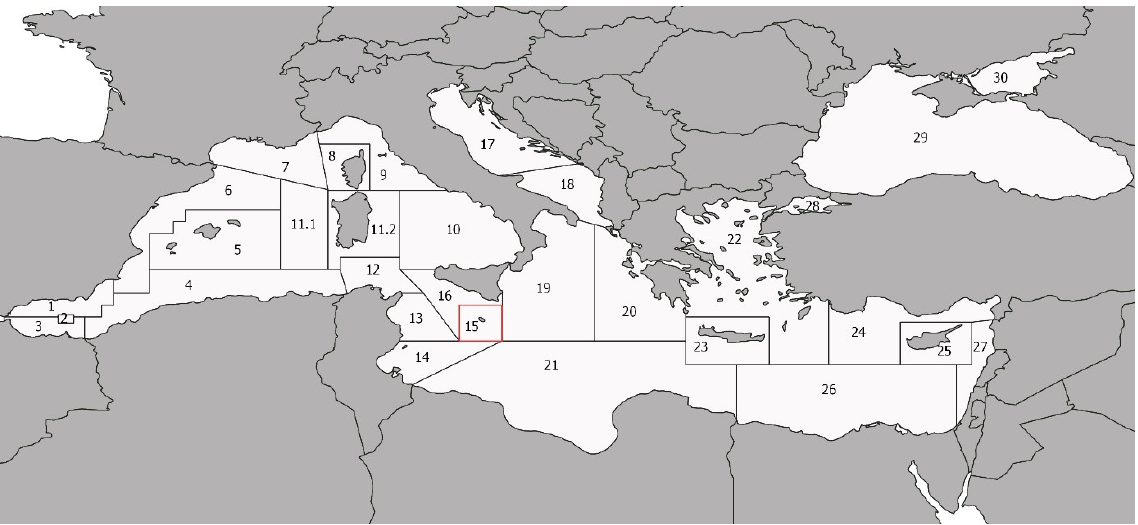
Figure 1. Map of the Mediterranean Sea indicating the boundaries of the Geographic Sub-Areas (GSAs) established by the General Fisheries Commission for the Mediterranean in 2009; the study area considered in the present work (GSA 15) is shown in red.